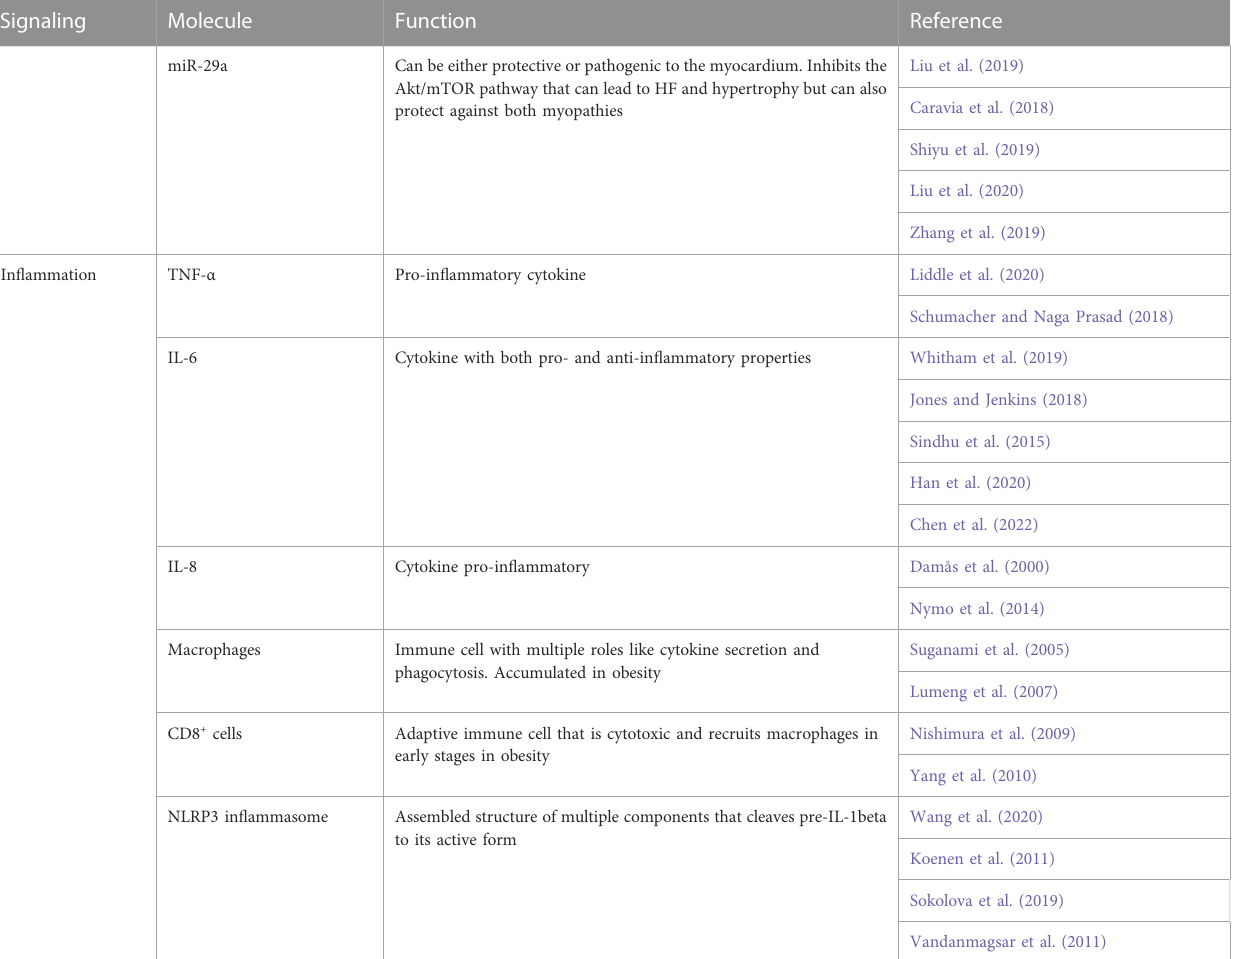
TABLE 1 ( Continued ) Overview of the literature describing the molecular basis of fat – heart